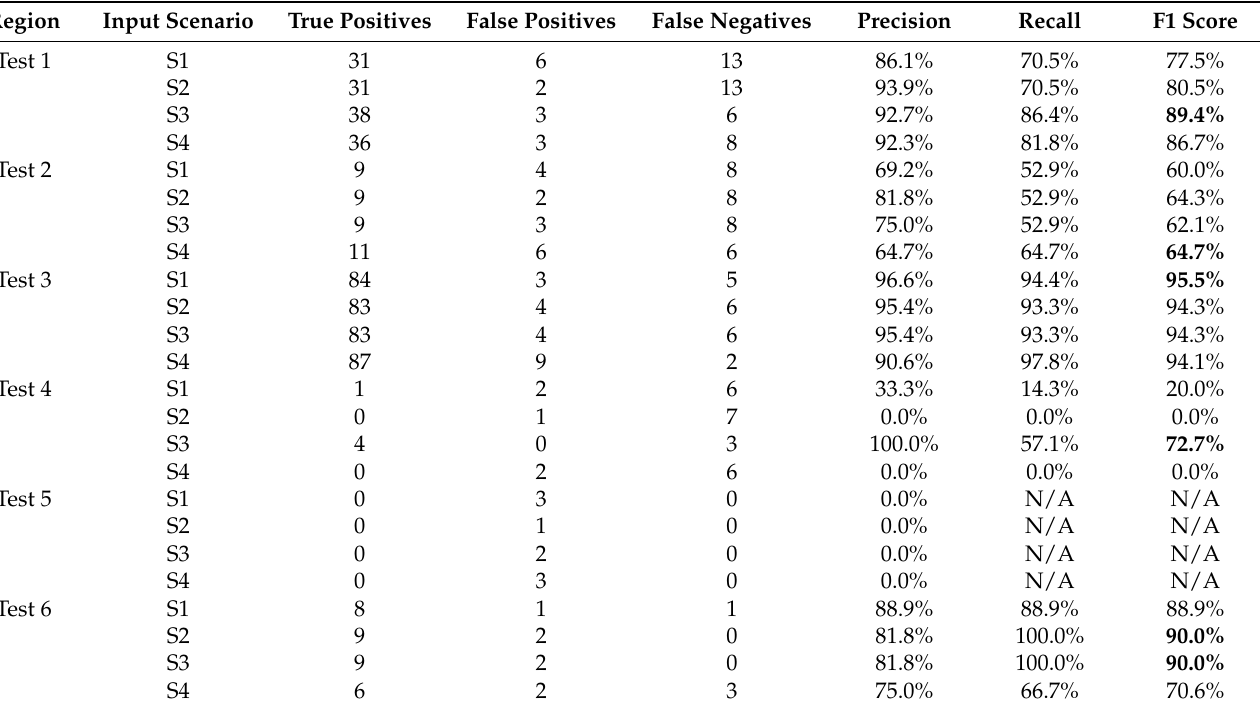
Table 4. Accuracy assessment results of six test regions. Bold text represents the highest F1 score in each test region.